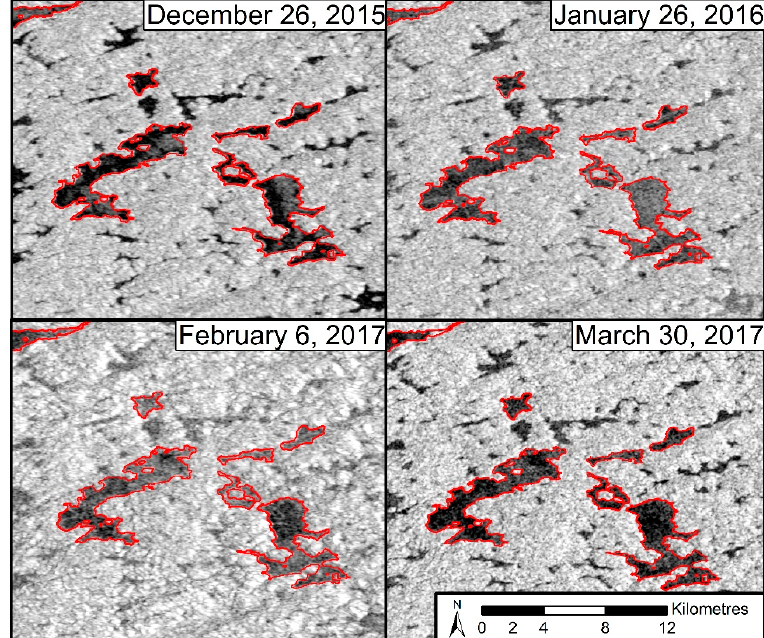
Figure 2. The top row (26 December 2015 and 26 January 2016) shows the transition in backscatter during ice growth with darker tones earlier (top left) progressing to lighter tones (top right). The bottom row (6 February 2017 and 30 March 2017) shows the transition in backscatter during the ice melt with lighter tones earlier (bottom left) progressing to darker tones (bottom right). RADARSAT- 2 Data and Products © MacDonald, Dettwiler and Associates Ltd. (2015; 2016)—All Rights